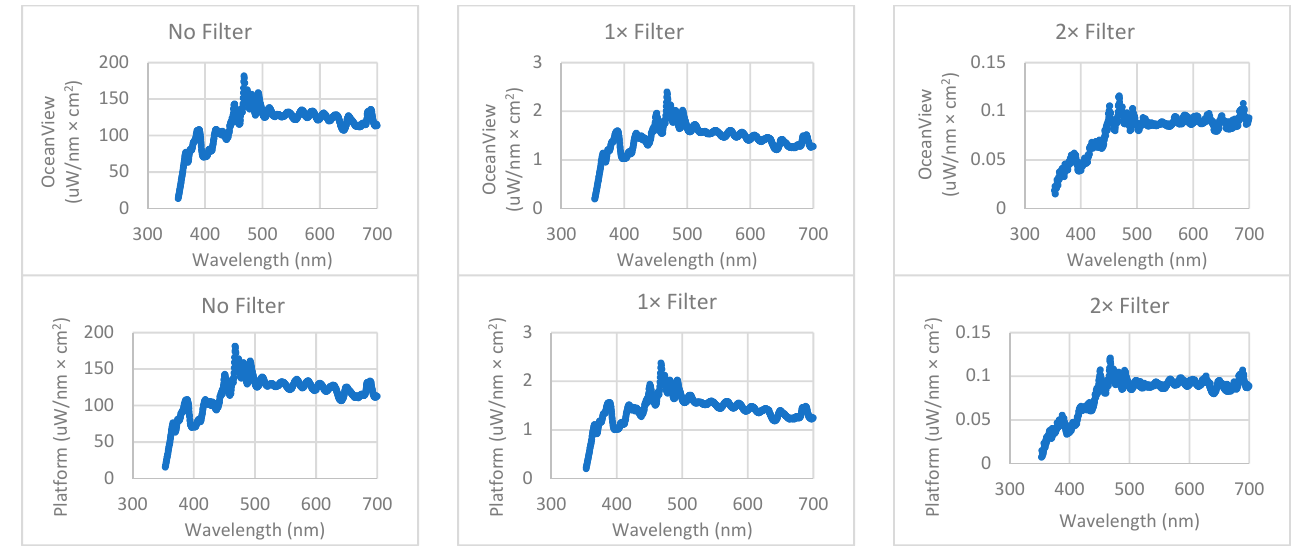
Figure 3. Each chart displays an average spectrum created by averaging three repeat spectral measurements. The top row shows the average spectrum of the platform-controlled measurements, and the bottom row shows the average spectrum of the OceanView controlled